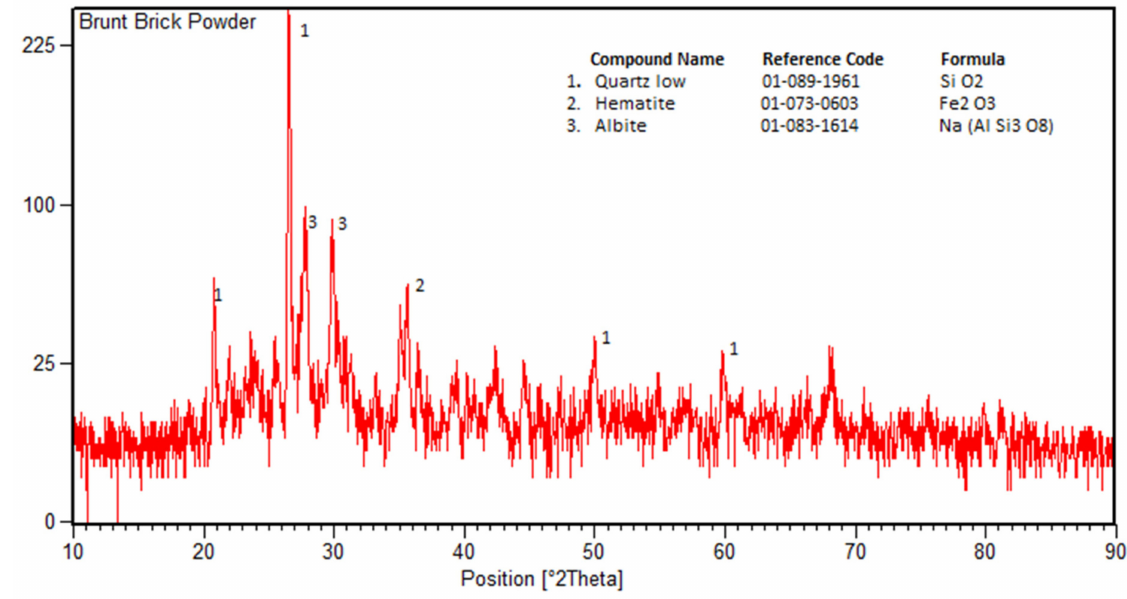
Figure 4. X-ray diffraction of waste burnt brick powder